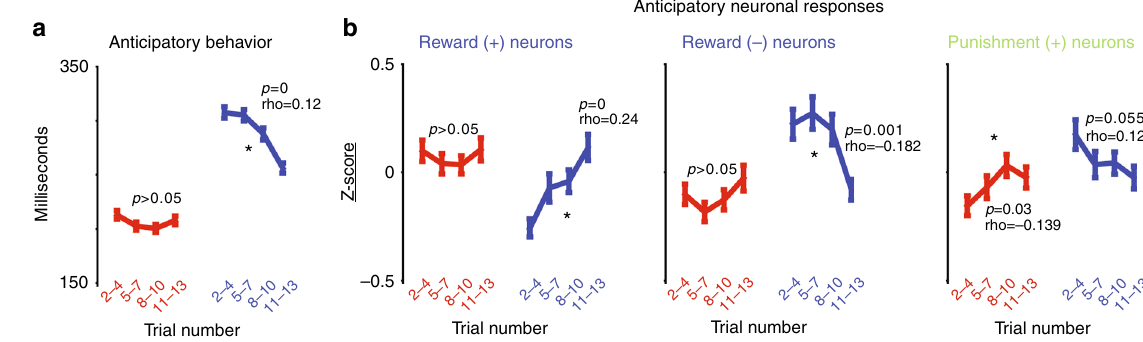
Fig. 4 Monkeys and ACC neurons anticipate the nearing of their preferred block. a Reward and punishment blocks of 12 trials were separated into four sub-blocks. The blocks were separated relative to the monkeys ’ knowledge about which block they were in. For example, the reward block starts after the fi rst reward CS trial after which the monkeys knew they were in the reward block. It ends during the fi rst punishment CS trial (because the monkeys had not yet seen the punishment CS). Hence, the block trial numbers in this fi gure are numbered 2 through 13. The average times of when monkeys foveated the trial start cue (relative to the time of the trial start cue presentation) are shown for the four sub-blocks in the reward block ( red , left ) and aversive block ( blue , right ). The results of a Spearman ’ s rank correlations assessing the relationship of sub-block number and speed of orienting to the trial start cue are indicated above each block. Asterisk highlights when a correlation was signi fi cant. Error bars denote standard error. b Responses of the three groups of valence-speci fi c neurons identi fi ed in Fig. 2 during the last 500 ms of the trial start cue epoch. Conventions are the same as in a . In all four plots, the data in the reward block ( red ) differed from the data in the punishment block ( blue ; rank sum test; p <